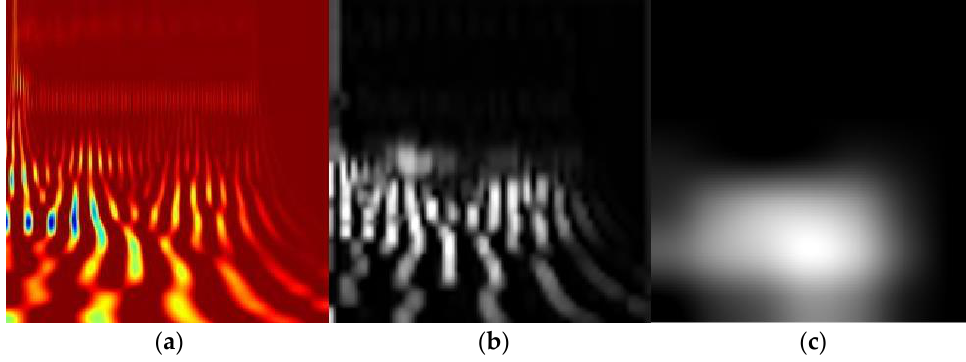
Figure 10. An example of discriminating cues from CWT images: ( a ) original image; ( b ) activating features in max pool layer 3 × 3; ( c ) activating features in inception (5b).